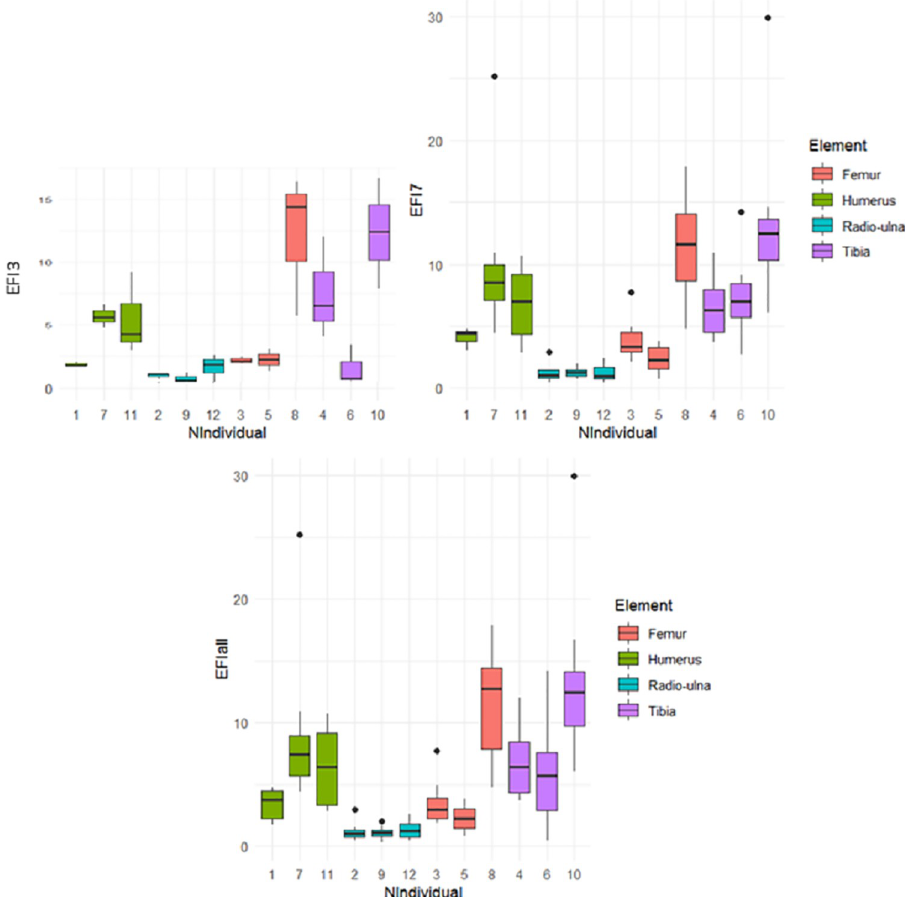
Fig 2. Box plots of the Efficiency Index. Efficiency Index by Individual during the experiment regarding the third first tries, the last seventh tries and all tries.